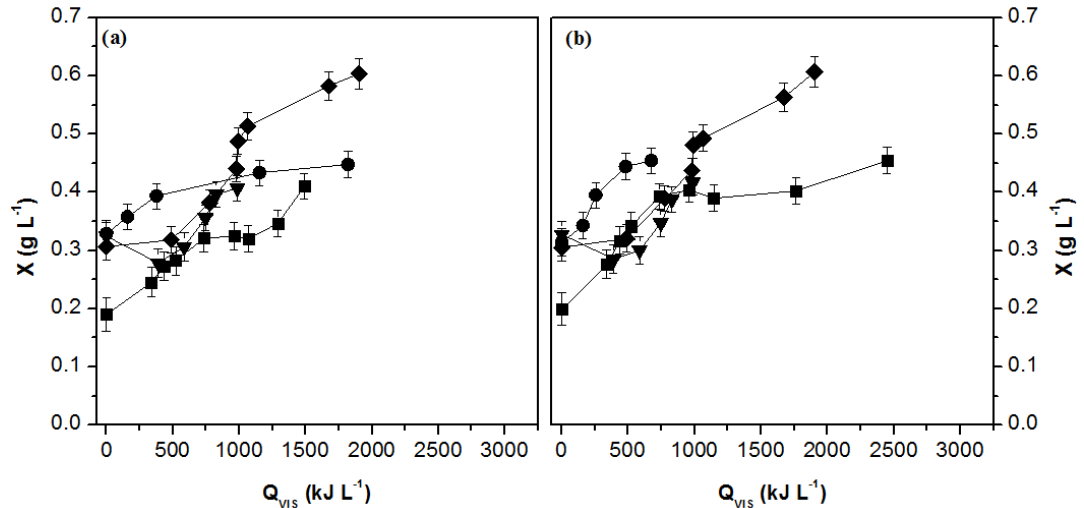
Figure 3. Variation of biomass dry weight concentration ( X ) as a function of the accumulated visible energy ( Q VIS ) in PBR 1 ( a ) and PBR 2 ( b ) for all assays: I— (cid:4) ; II— • ; III— (cid:72) ; IV— (cid:7) . Error bars correspond to the standard deviation of the mean determined for duplicates from two independent experiments.